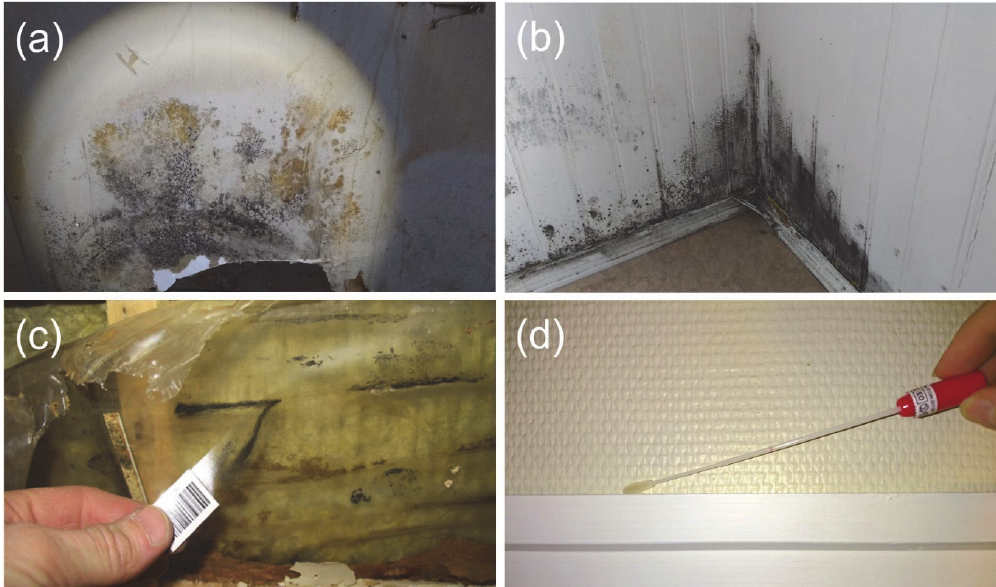
Figure 1. Sampling of mold and dust in this study. ( a ) Mold-damaged gypsum board where M62- M64 samples were collected; ( b ) mold growing on wood, sample M65; ( c ) tape lifts taken directly on discoloration of building materials; ( d ) dust sample collected by swabbing the upper doorframe, picture extracted from Martin-Sanchez et al. [22].